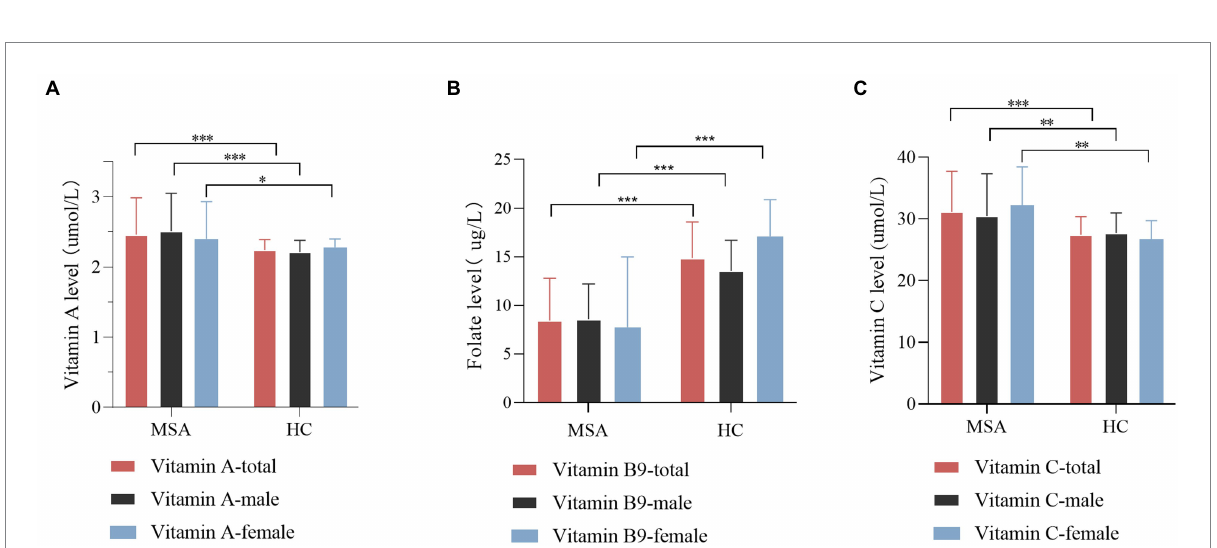
FIGURE 2 Comparison of vitamin A, B9, and C levels between MSA patients and healthy control (HC), according to gender. (A) Comparison of vitamin A level between control and MSA groups. MSA (male) vs. control (male), *** p < 0.001; MSA (female) vs. control (female), * p = 0.024. (B) Comparison of vitamin B9 level between control and MSA groups. MSA (male) vs. control (male), *** p < 0.001; MSA (female) vs. control (female), *** p < 0.001. (C) Comparison of vitamin C levels between control and MSA groups. MSA (male) vs. control (male), ** p = 0.001; MSA (female) vs. control (female), ** p =